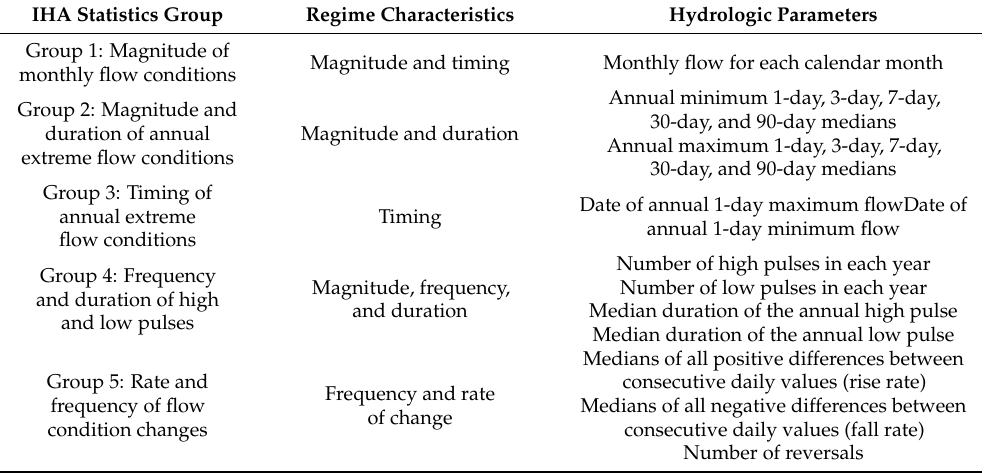
Table 1. Summary of hydrologic parameters used in the